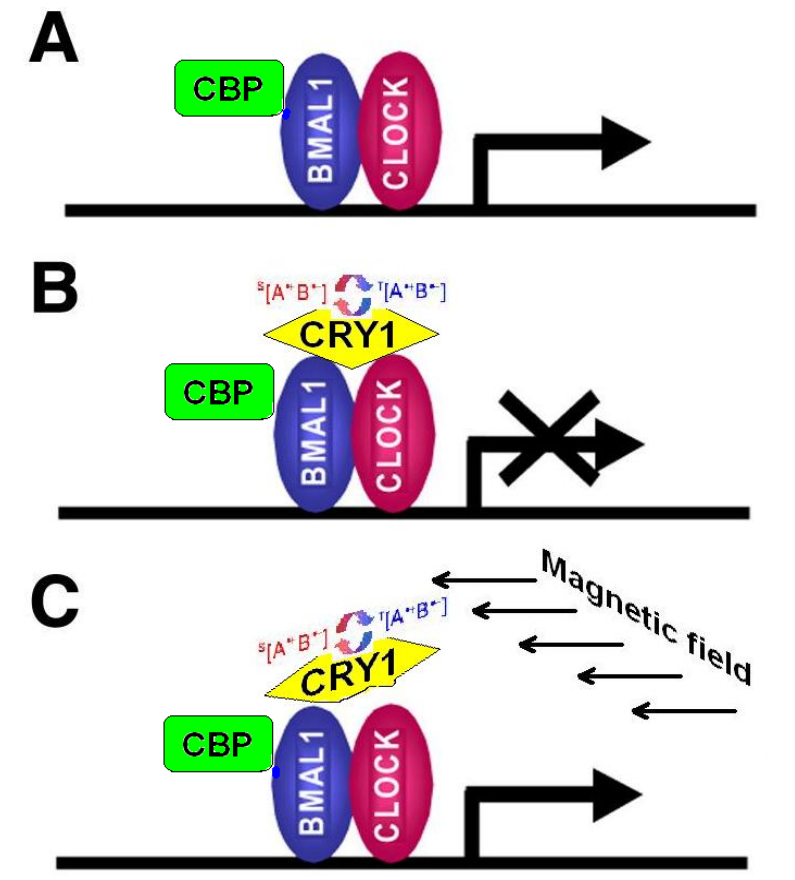
Figure 6. Scheme representing possible mechanisms of CRY bio-regulating activity. (a) CLOCK/BMAL1-heterodimer function as transcriptional activator. (b) interaction between CRY1 and CLOCK/BMAL1 causes CLOCK/BMAL1 to adopt a transcriptional repression function. (c) modification of CRY activity by weak external magnetic field and subsequent restoration of CLOCK/BMAL1 transcriptional activation function. CBP : CREB-binding